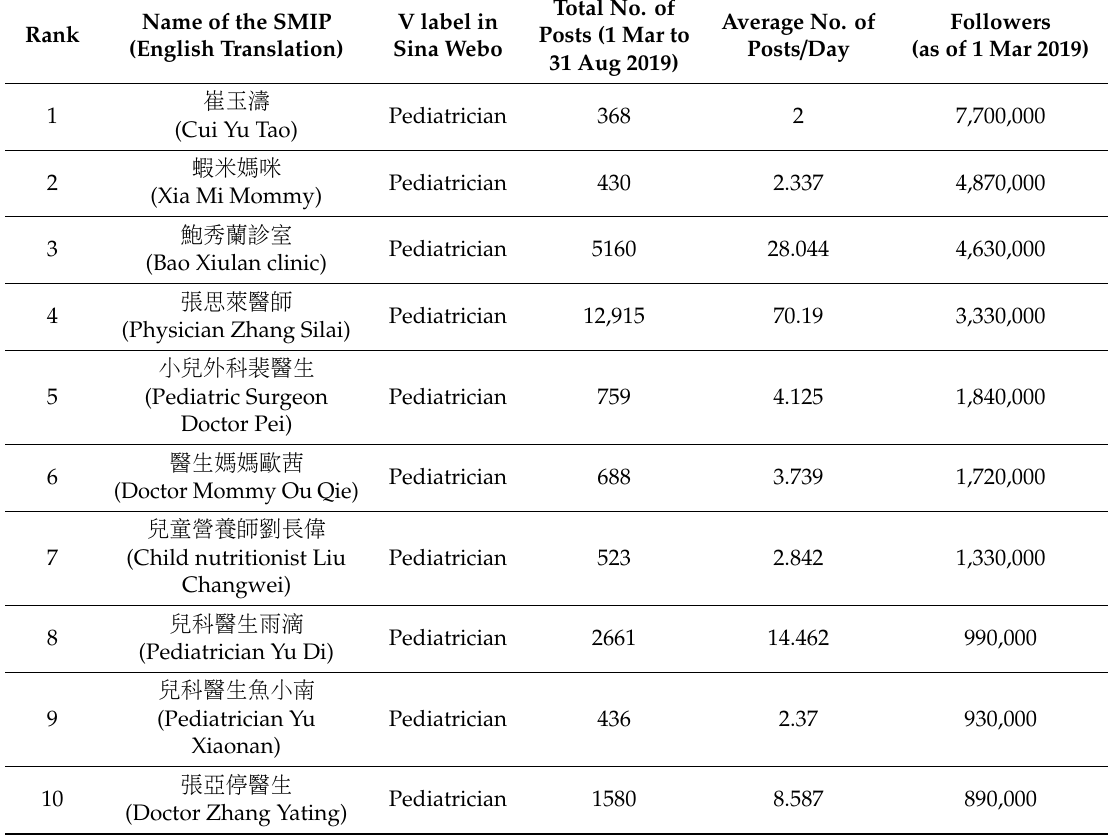
Table 1. Top 10 SMIP in Sina Weibo and the total number of their postings and